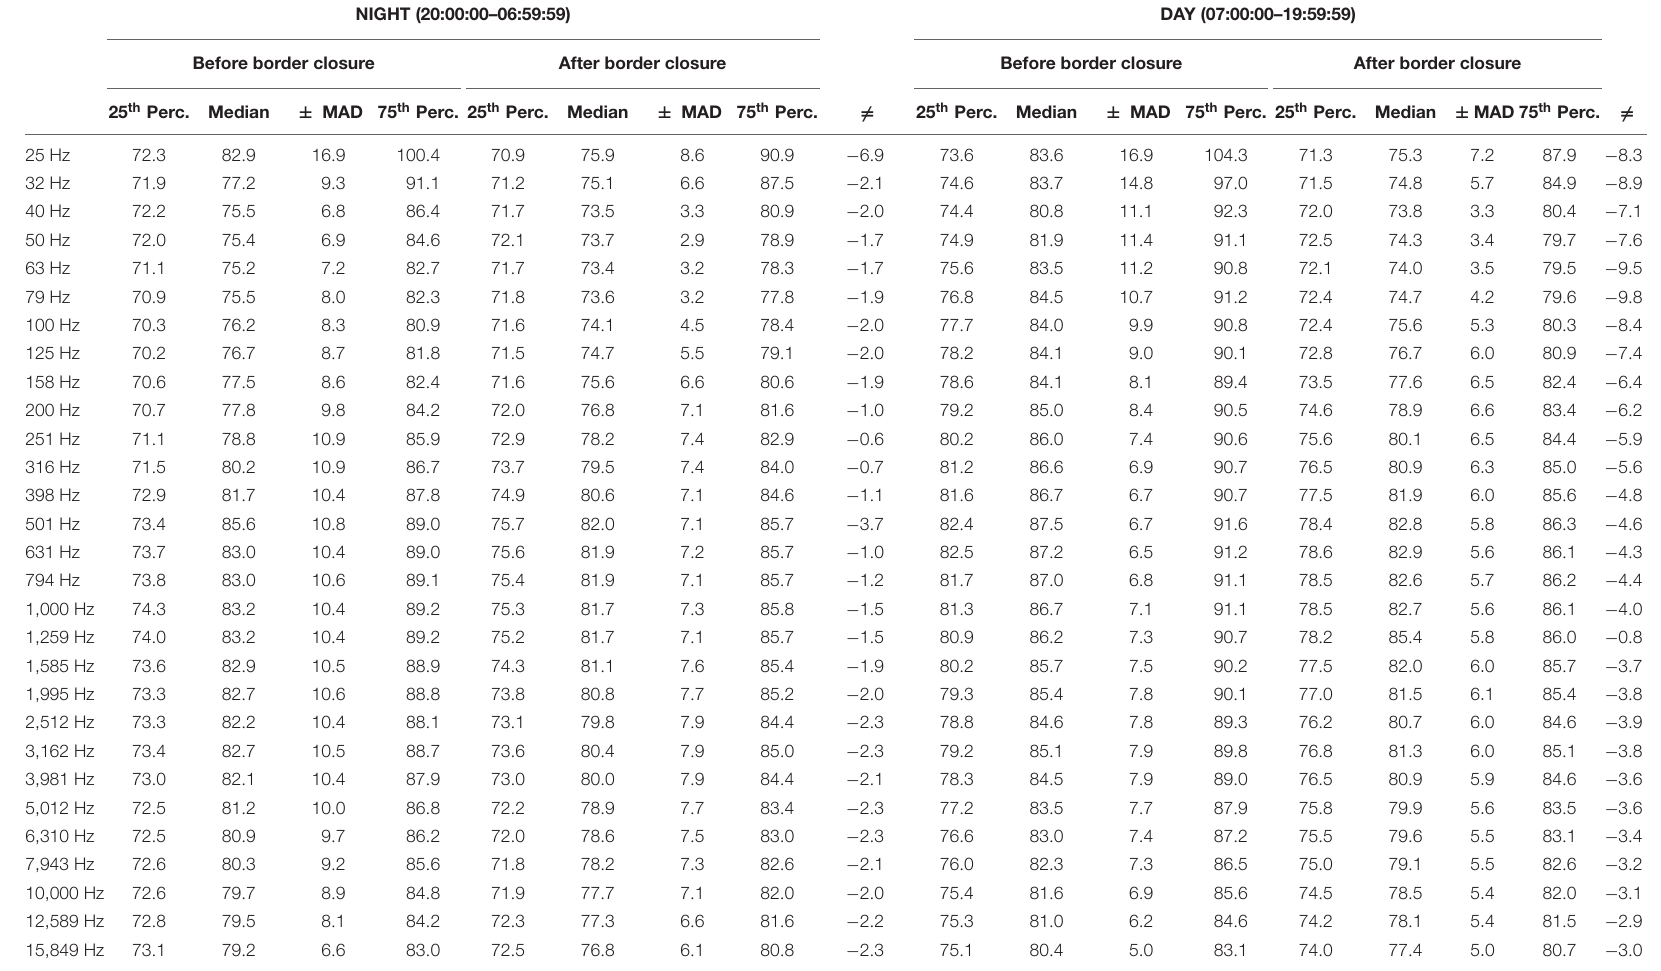
TABLE 3 | Median noise levels (dB re 1 µ Pa) of the 1/3 octave